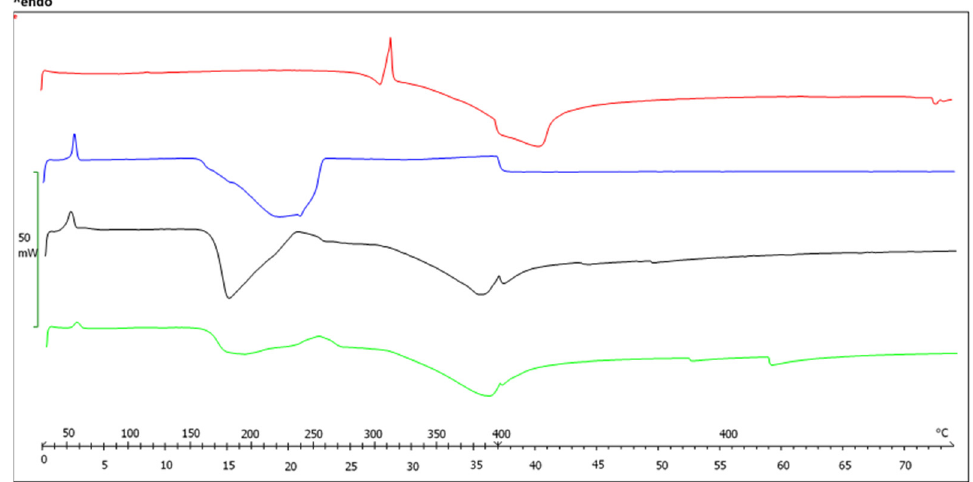
Figure 1. DSC thermograms of original OA (red), Poloxamer 407 (blue), PM OA-P407 1:2 (black), and SEM OA-P407 1:2 (green).